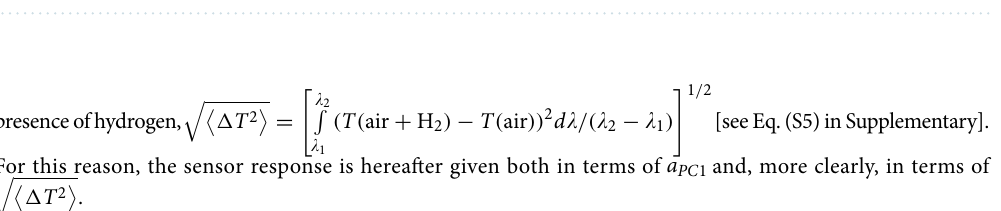
Figure 2. Measured (solid) and calculated (dashed) transmission spectra of the sensing element for the E ⊥ (red) and E || (blue) polarizations.